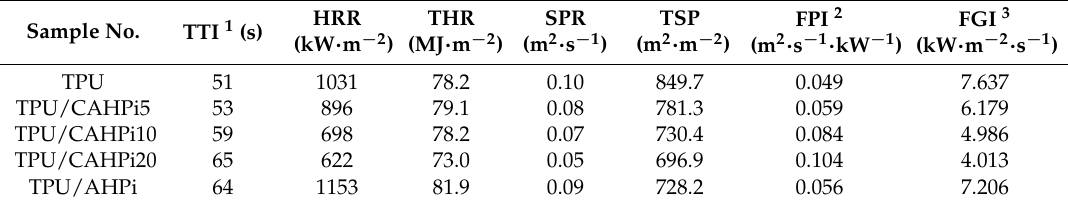
Table 2. Related cone calorimeter data for TPU and its nanocomposites at 35 kW · m − 2 . Sample No.